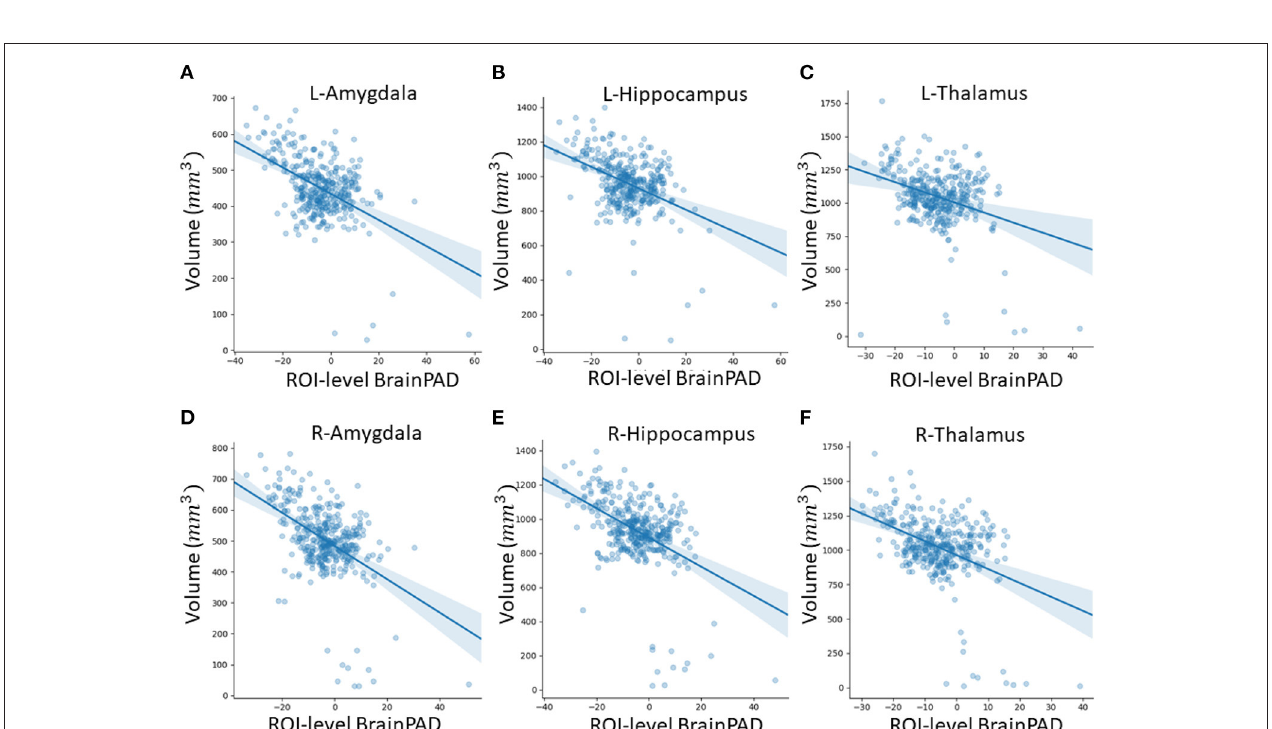
FIGURE 5 | Scatterplots of ROI-level brain-PAD and brain volume (mm 3 ). Volumes were generated using regional templates from the Harvard-Oxford atlas. (A) Left amygdala. (B) Left hippocampus. (C) Left thalamus. (D) Right amygdala. (E) Right hippocampus. (F) Right thalamus.